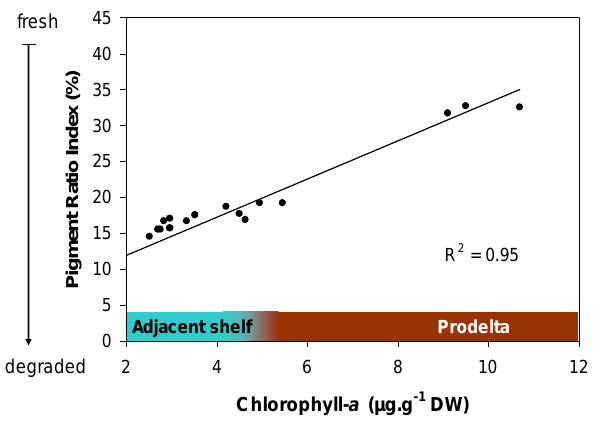
Fig. 2. Correlation between Pigment Ratio Index values (PRI %) and chlorophyll- a concentration in surface sediments off the Rhˆone River mouth (16 stations, 48